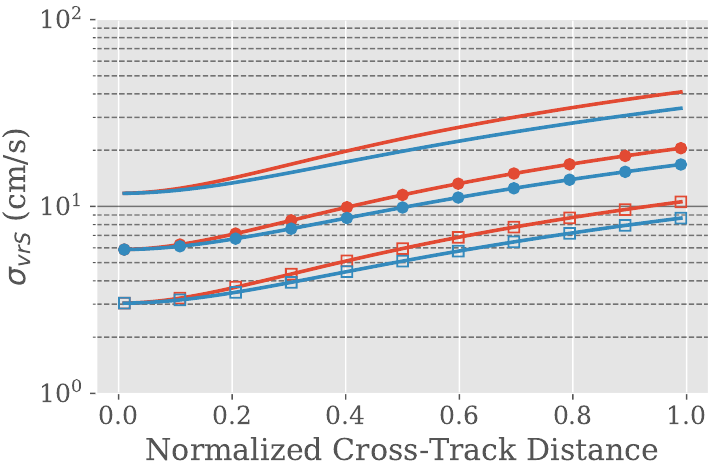
Figure 12. Surface-projected radial velocity error as a function of normalized cross-track distance from nadir for antenna lengths, L , of 4m (red) and 5m (blue) and for peak output power of 100W (no marker), 400W (filled circles), 1.5kW (empty rectangles).